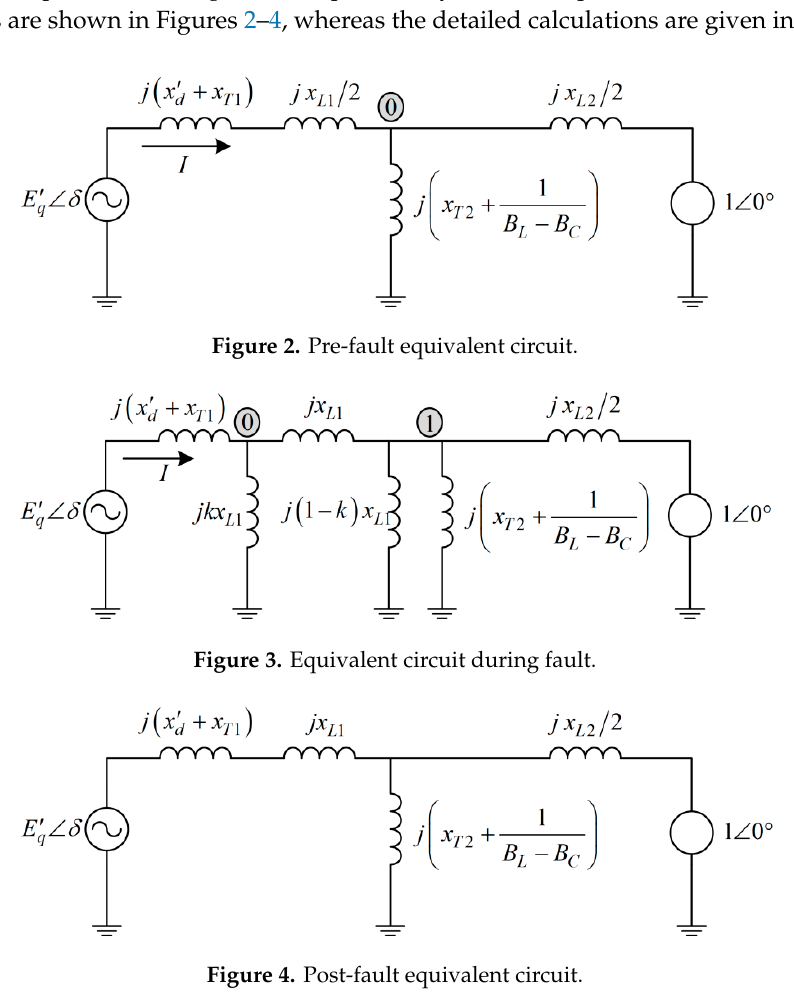
Figure 4. Post-fault equivalent circuit.